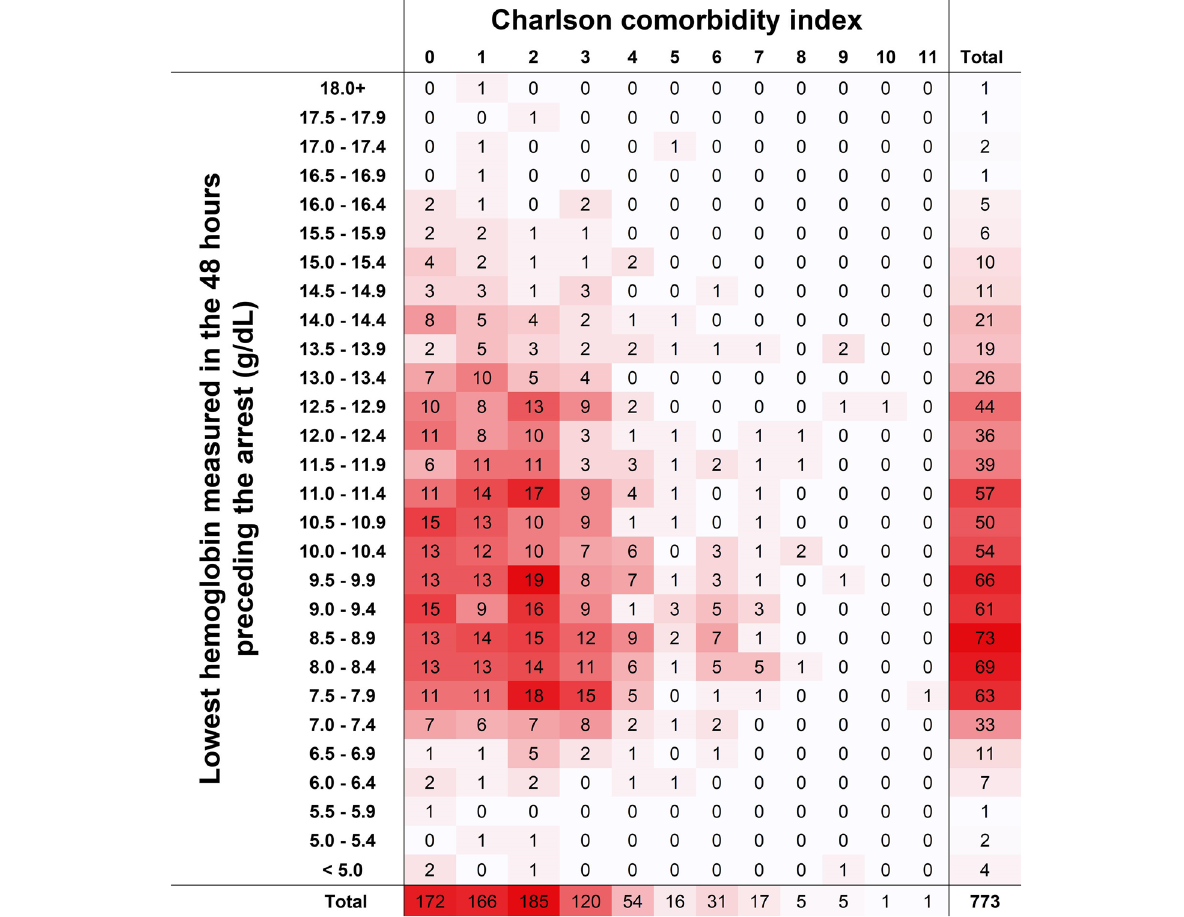
Fig. 2 Heat map of Charlson comorbidity index versus lowest hemoglobin measured in the 48 h preceding the arrest (g/dL). Heat map showing the distribution of hemoglobin measurements between CCI scores highlighting that with lower hemoglobin measurements CCI